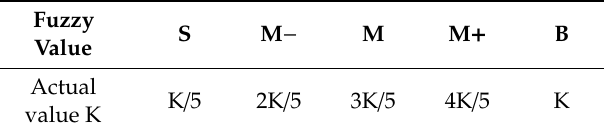
Table 3. The actual output of fuzzy parameters.